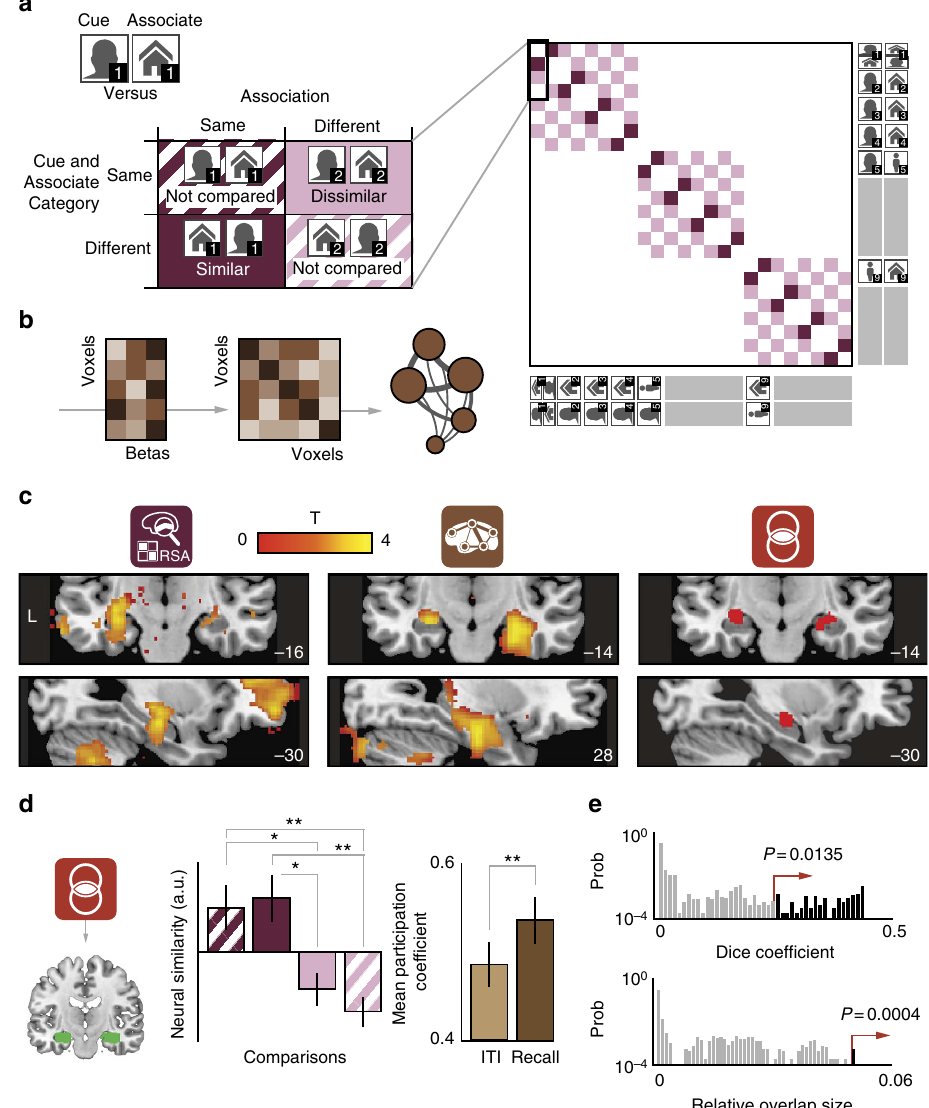
Figure 2 | Conjunctiveness and hubness in the hippocampus. ( a ) Representational similarity analysis (RSA) logic. Left: associative similarity contrast, with expected high regional representational similarity for comparisons of the same association, and low similarity for comparisons of different associations, yielding a conjunctiveness metric for each voxel. Specific comparisons were excluded to penalize perceptually driven effects (striped/blank cells): within- association comparisons with identical cue or associate stimulus categories (top left quadrant in matrix), and between-association comparisons with different cue and associate stimulus categories (bottom right quadrant). Right: full condition-by-condition RSA contrast matrix used in the whole-brain searchlight approach. Each cell represents a specific comparison between two conditions. Darkness indicates degree of expected pattern similarity. Four example comparisons are outlined. ( b ) Logic of network analysis. Whole-brain beta time-series correlation (left, five example voxel time series) was performed to obtain a voxel-by-voxel functional connectivity matrix (middle, darker shades indicate higher correlation coefficients). The participation coefficient was computed to obtain a hubness metric for each voxel, reflected by node size in the example graph (right, thickness of the edge relates to connectivity strength). ( c ) Both RSA and network analysis show significant effects in the hippocampus ( P o 0.05 small-volume-corrected, thresholded at P o 0.05 uncorrected for display purposes) and overlap of both effects. ( d ) Hippocampal voxels showing overlapping effects were selected (left) to extract normalized similarity estimates (middle) for each comparison shown in a and hubness scores for ITI and recall periods (right). * P o 0.05, ** P o 0.005. Note that comparisons between these bars are shown for display purposes only and reflect the effect shown in c for the selected hippocampal overlap voxels. ( e ) Observed Dice coefficient and relative overlap size (proportion of voxels showing overlap) of the hippocampus and associated P -value based on the null-distribution from the label shuffling (spatial resampling) procedure. Histogram y axis depicts the probability of observing a certain overlap statistic in randomly selected ROI (prob) on a logarithmic scale. The hippocampus shows significantly more overlap of conjunctiveness and hubness metrics than other regions in the Methods and Fig. 2a for details). The final contrast resulted in a P ¼ 0.045 small-volume family-wise error (FWE) corrected using conjunctiveness score for each individual voxel (Fig. 2c left Threshold-Free Cluster Enhancement, see Methods for details). panel). As predicted, the hippocampus showed a significant We found no significant differences in other brain regions in a conjunctiveness effect (peak Montreal Neurological Institute follow-up analysis ( P 4 0.17 whole-brain FWE-corrected, see (MNI) coordinates: x , y , z ¼ [ (cid:2) 30, (cid:2) 16, (cid:2) 14], t 24 ¼ 3.59, Supplementary Fig. 1A).